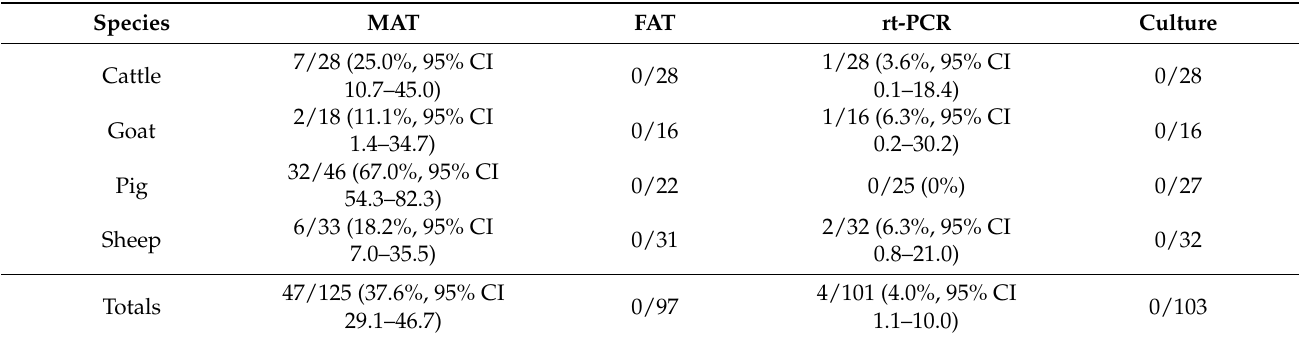
Table 3. Results (positive/total) of livestock serum and urine samples tested using MAT, FAT, rt-PCR and culture by animal species in St. Croix, U.S. Virgin Islands †